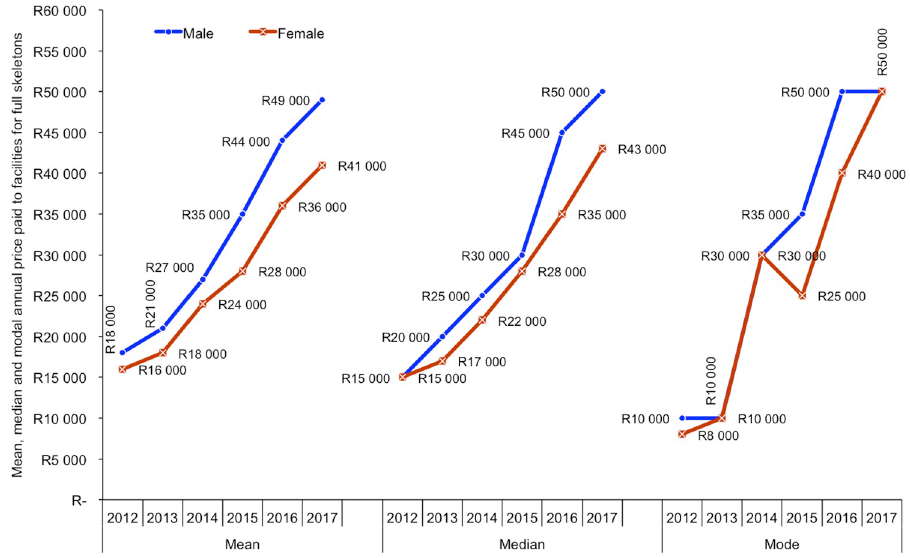
Fig 9. Comparative annual mean, median and modal prices of male and female lion skeletons (2012–2017) sold by responding facilities (n = 35) (mean annual prices, and sample sizes, for male and female lions in Figures Q–T in S1 Figs). Graph showing values in USD in Figure O in S1 Figs, where mean ZAR:USD exchange rates: 2012 (1: 0.122); 2013 (1: 0.104); 2014 (1: 0.092); 2015 (1: 0.078); 2016 (1: 0.068); 2017 (1: 0.075). Results correspond to Questions